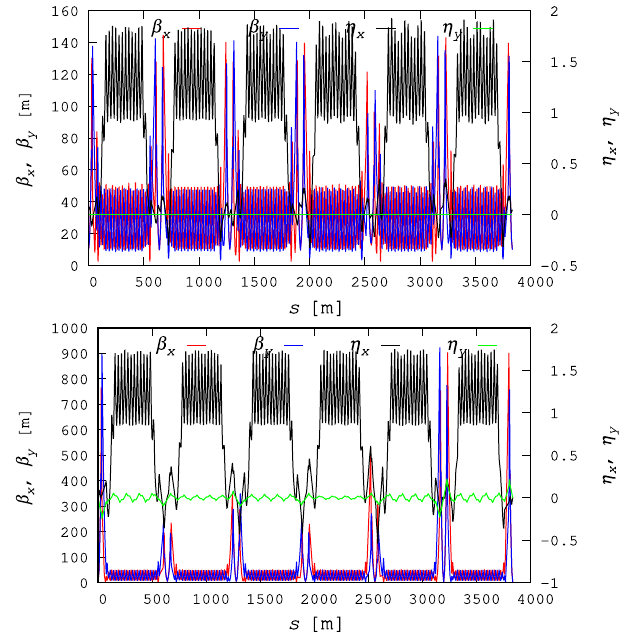
FIG. 10. For reference, optical functions in RHIC Run 22 Yellow lattice injection (top) and 255 GeV (bottom) nominal models, prior to any insertion of snake or rotator OPERA field maps and their local centering bumps. The small vertical dispersion at 255 GeV results from vertical orbit separation bumps at the six interaction points (Sec. III B). Origin of s is at IP6 (STAR detector), s increases going CCW.